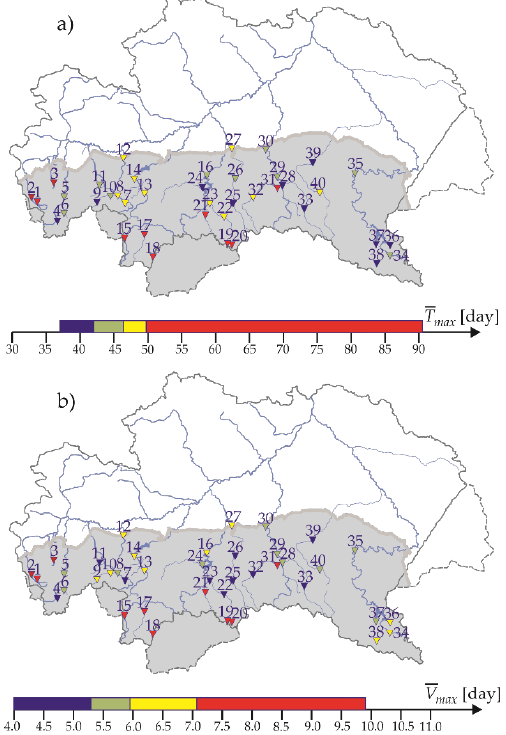
Figure 5. Spatial distribution of: ( a ) mean drought duration T max ; and ( b ) mean drought volume V max , according to the quartile classification, including the box and whiskers plots in the hydrological period between 1991 and